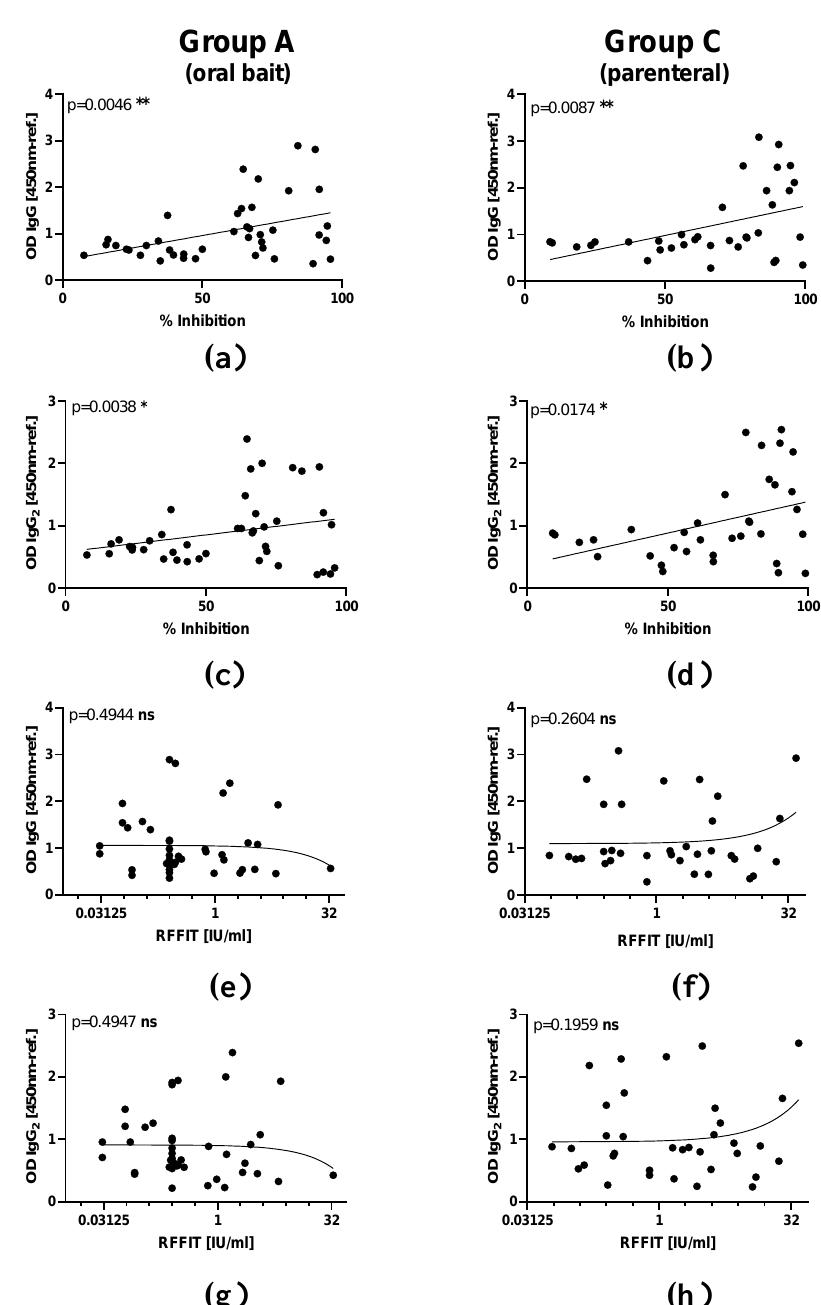
Figure 4. Comparison of correlation between optical density (OD) values of RABV specific immunoglobulins (IgG isotypes) and binding as well as VNAs after parenteral vaccination with an oral rabies vaccine (SPBN GASGAS) between orally (Group A and B) and parenterally (Group C) vaccinated animals. Correlation of RABV-specific IgG ( a , b ), and IgG2 ( c , d ) with rVBA as measured by ELISA. Correlation of RABV-specific IgG ( e , f ), and IgG2 ( g , h ) with rVNAs as measured by RFFIT. Each dot represents the results of one individual animal at di ff erent time points pv. Linear regression lines (solid lines) and the p -values are